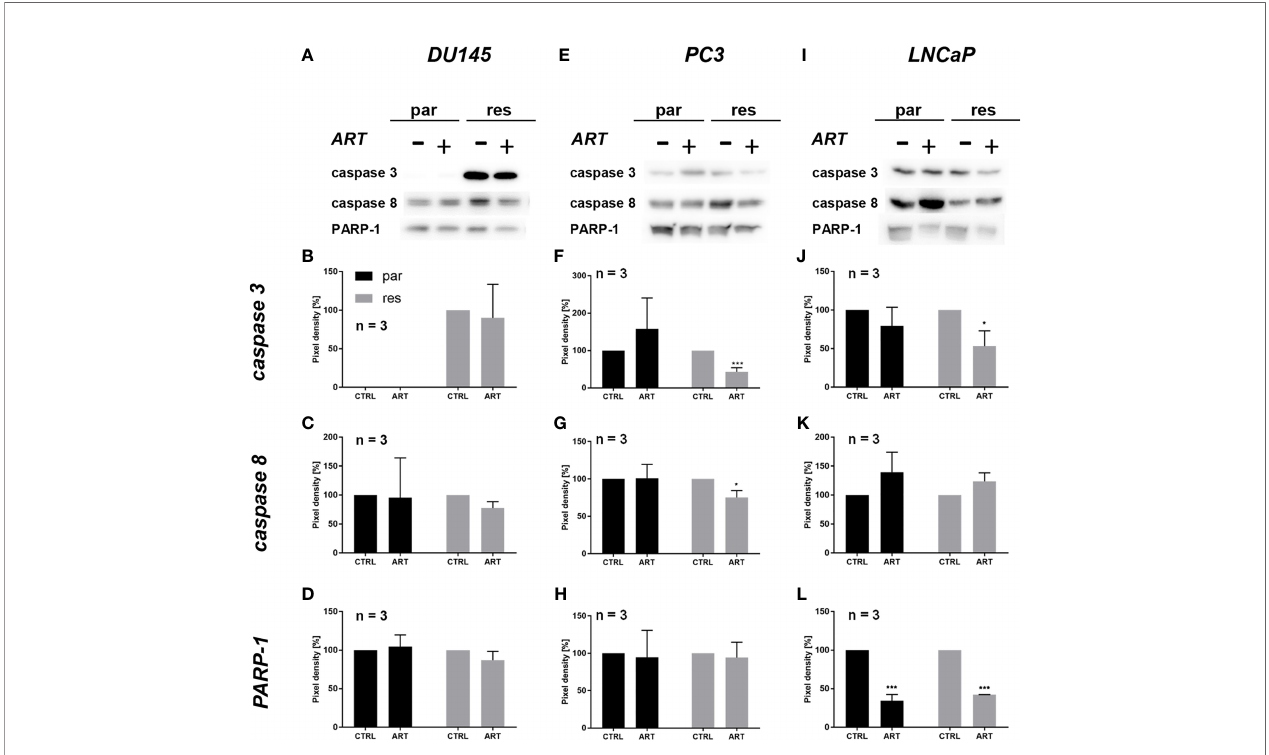
FIGURE 6 | Apoptotic signaling: representative Western blot images of apoptosis-related proteins in parental (par) and DX-resistant (res) DU145 (A) , PC3 (E) and LNCaP (I) cells with (+) and without (-) ART. Pixel density of caspase 3 (B, F, J) , caspase 8 (C, G, K) and PARP-1 (D, H, L) expression in parental (par) and DX- resistant (res) cells. All protein analysis was normalized by a total protein control. Untreated cells served as controls (100%). Error bars indicate standard deviation (SD). Signi fi cant difference indicated by: *p ≤ .05, ***p ≤ .001. n = 3. For detailed information regarding the Western blots, see Figures S2.1 – 9